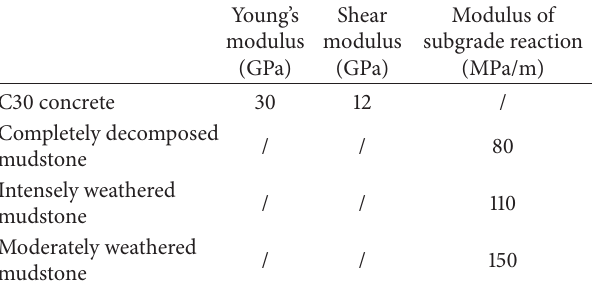
Table 1: Parameters of material